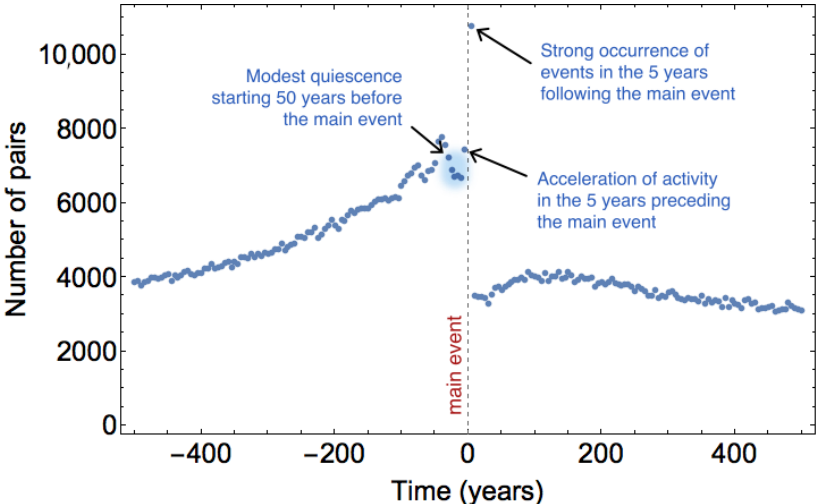
Figure 7. Stacked number of M w ≥ 4.2 earthquakes that preceded and followed an M w ≥ 5.2 earthquake within an epicentral distance of 20 km in 100,000 years simulated